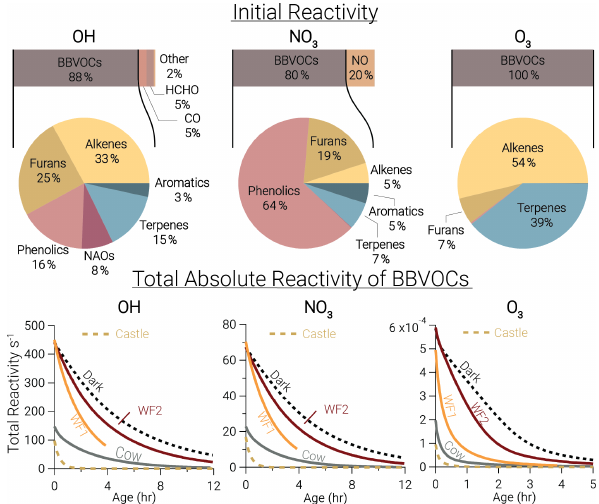
Figure 3. Bars: average (of all five model runs) initial relative in- stantaneous reactivity for all compounds in our model, showing that initial reactivity of BBVOCs outweighs all other compounds for all oxidants. Pie charts: initial relative reactivity of BBVOCs, show- ing that OH reactivity is controlled by many BBVOC groups, NO 3 reactivity by phenolics, and O 3 reactivity by alkenes and terpenes. Time series: absolute reactivity of for all model runs, showing that reactivity decays at different rates for each model run and that OH and NO 3 reactivity decay is